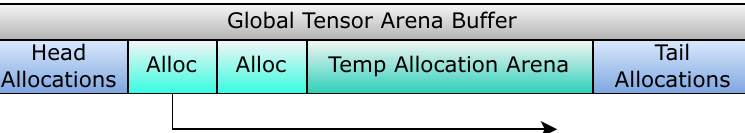
Figure 14. Dual-stack allocation